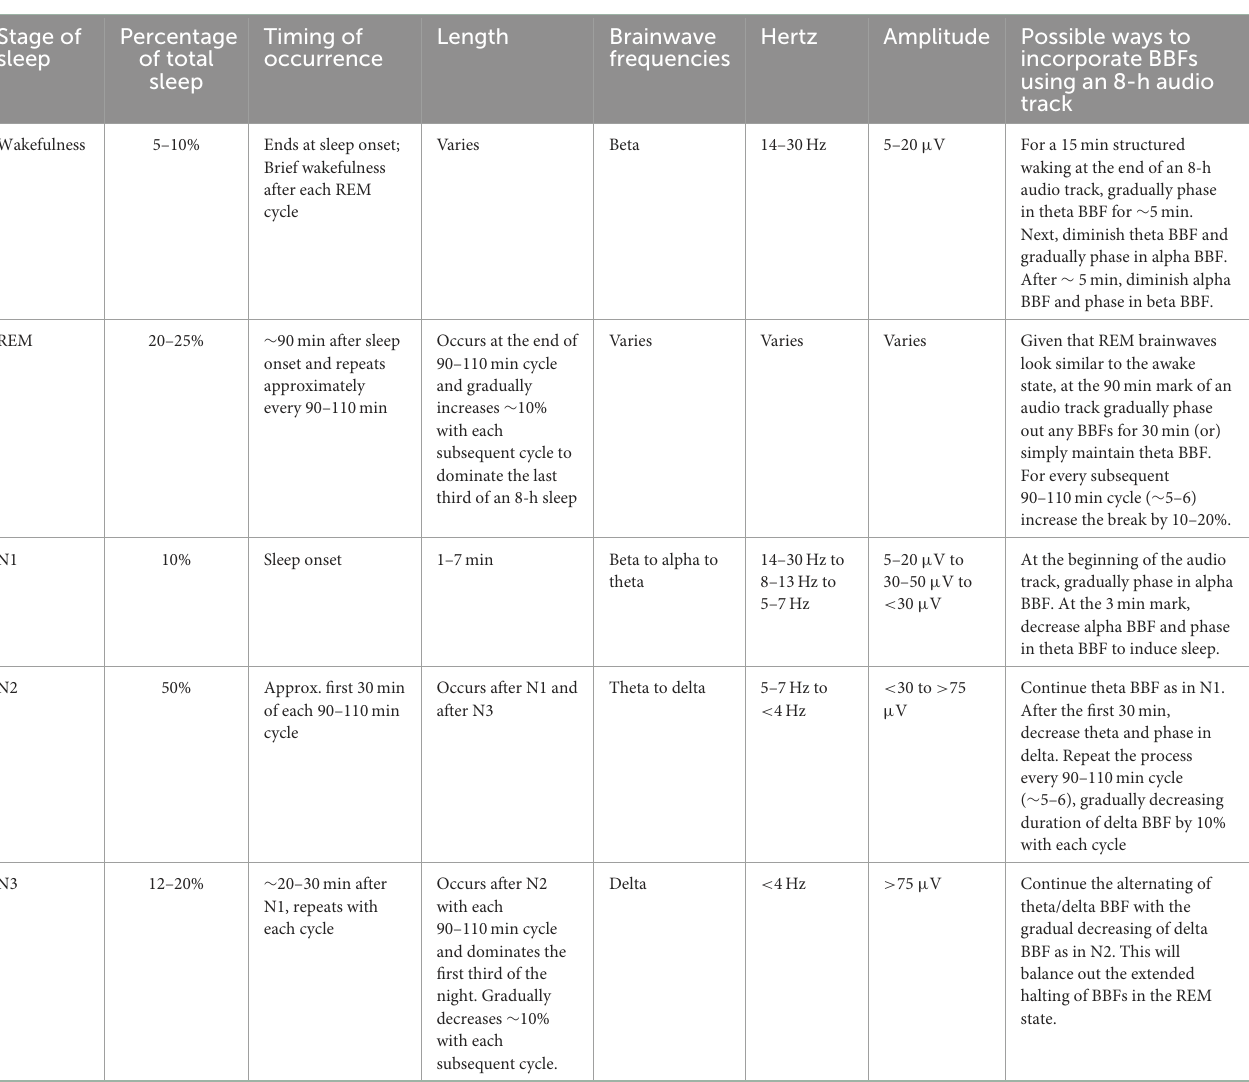
TABLE 1 Hypnogram summary and possible ways to use binaural beat frequencies. Stage of Percentage sleep of total